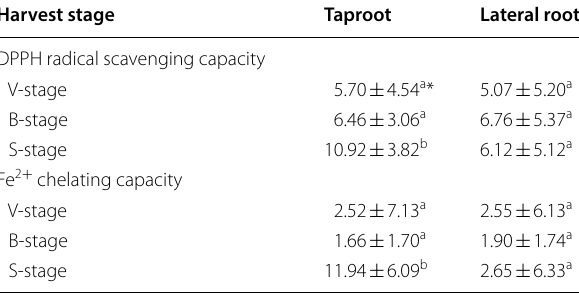
Table 2 Antioxidant activity of Baizhi taproot and lateral root at three growth stages